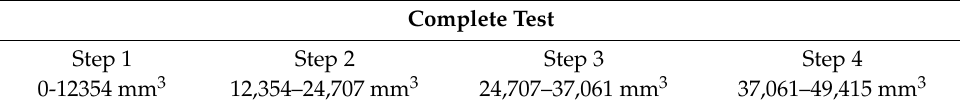
Table 3. Range of material removed from the workpiece for each step of a given test.